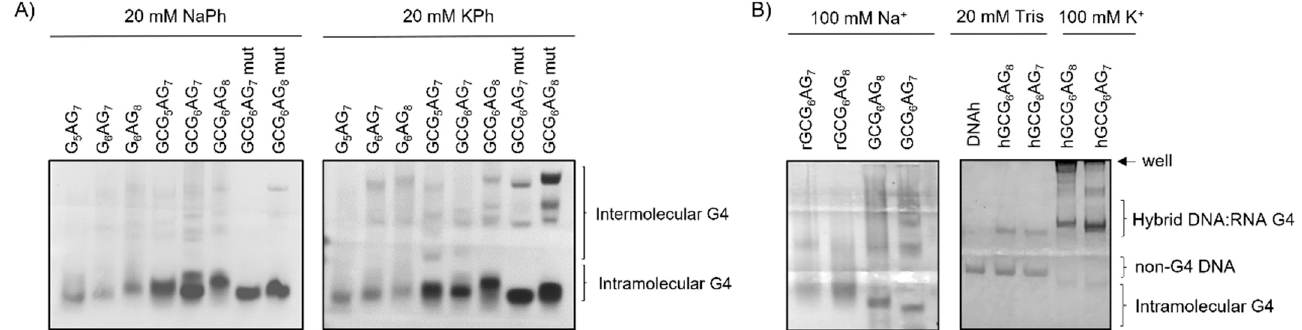
Figure 8. ( A ) Polyacrylamide gel electrophoresis developed with ThT for different DNA sequences in 20 mM sodium phosphate and 20 mM potassium phosphate (cation concentrations = 30 mM); ( B ) polyacrylamide gel electrophoresis developed with ThT for RNA (rGCGXAGY) and DNA (GCGX- AGY) sequences in 100 mM Na + and for DNAh and DNA:RNA (DNA:RNA-hGCGXAGY) sequences in 20 mM Tris (no cation) and 100 mM K + .